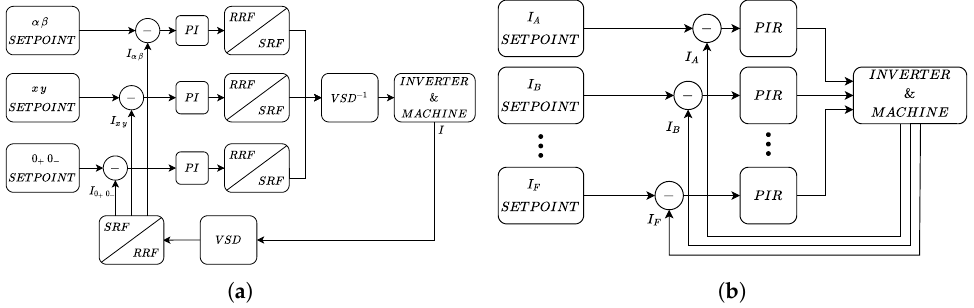
Figure 4. Overview of the examined control techniques: ( a ) vector space decomposition (VSD) and ( b ) resonant current control.